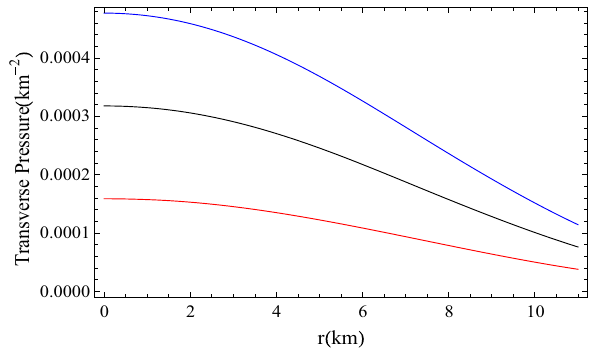
Fig. 7 Variation of the radial pressure gradient of PSR J0348+0432 for β = 1 (red), β = 2 (black) and β = 3 (blue) (considering α = 0 .